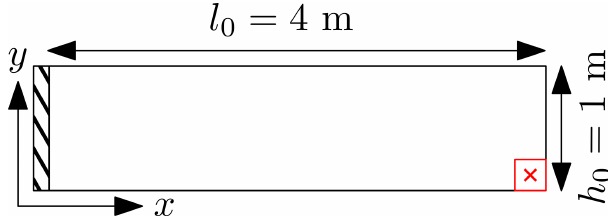
Figure 11. Initial geometry for the cantilever beam problem; the free end material point appears in red, and a red cross marks its